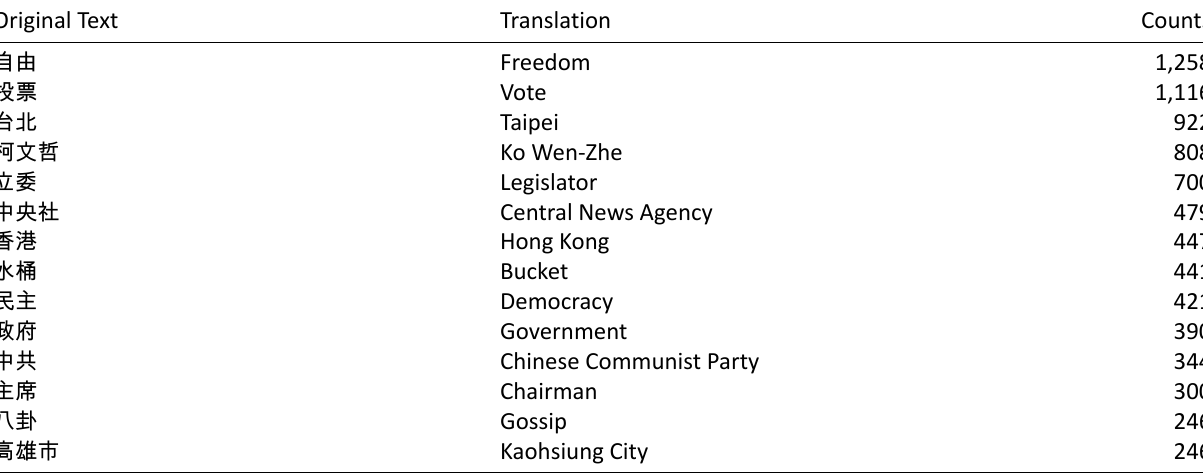
Table 5. Top words found within the PTT bulletin board.